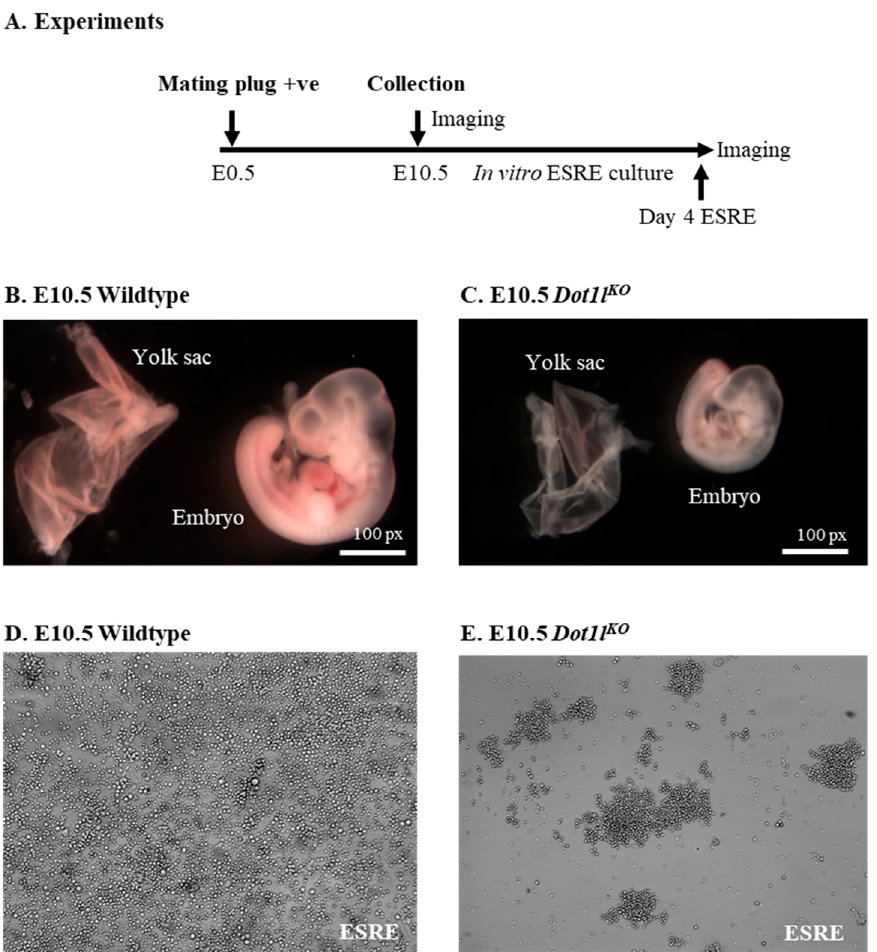
Figure 1. Dot1l KO progenitors failed to proliferate in response to EPO. ( A ) Schematic diagram showing the timeline of the embryo and yolk sac collection and in vitro culture of yolk-sac-derived erythroblasts. Representative images of E10.5 wild-type and Dot1l KO yolk sacs and embryos ( B , C ). Both the Dot1l KO yolk sacs as well as the embryos were smaller than those of the wild type ( B , C ). Cells were isolated from E10.5 wild-type and Dot1l KO yolk sacs and equal numbers were cultured in extensively self-renewing erythroblast (ESRE) culture medium as described. The cells were then differentiated from the definitive erythroid progenitors into erythroblasts ( D , E ). Compared to the wild-type erythroblasts ( D ), Dot1l KO erythroblasts had severely reduced numbers ( E ).